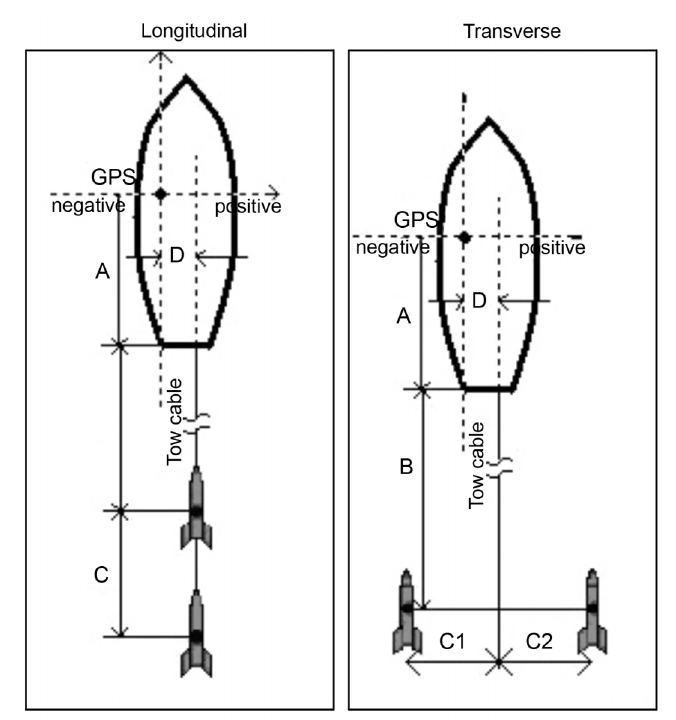
Fig. 1. The geometry of the two G880 sensors: transverse and longitudinal gradiometric scheme.